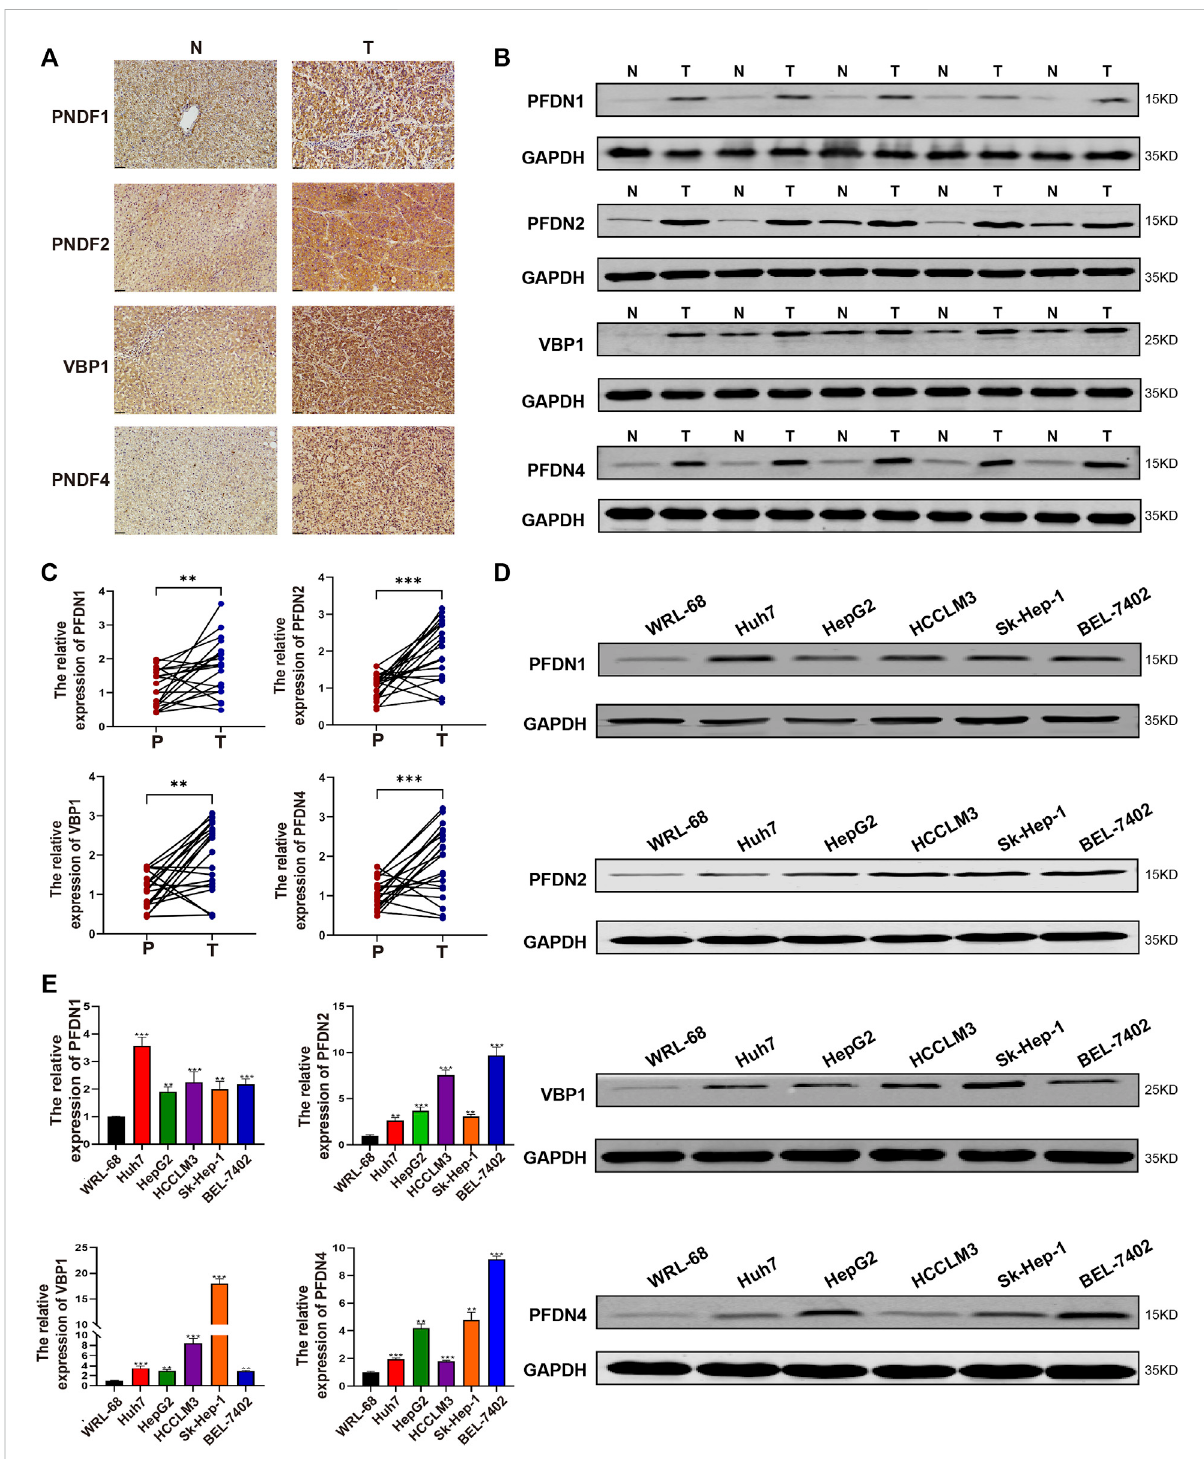
FIGURE 7 ExpressionofPFDN1 – 4inclinicalsamplesandHCCcelllines. (A – C) ExpressionofPFDN1/2/3/4inHCCsamples(IHC,WB,andreal-timeqPCR). (D,E) Expression of PFDN1/2/3/4 in the normal liver cell line and HCC cell lines (real-time qPCR,